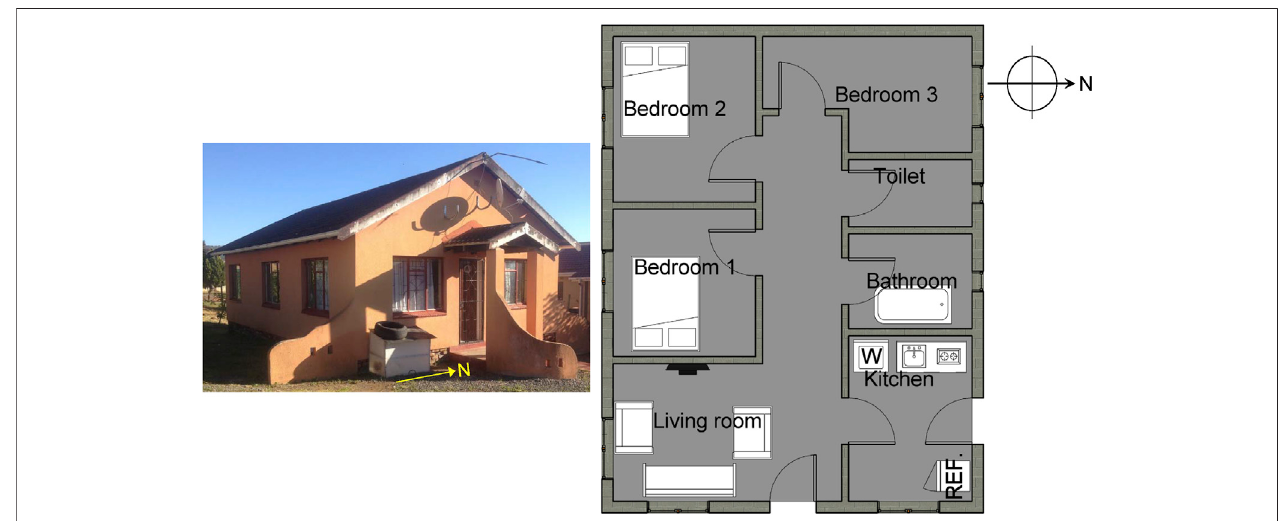
FIGURE 3 | Photo of the conventional house used in the study and its fl oor layout.